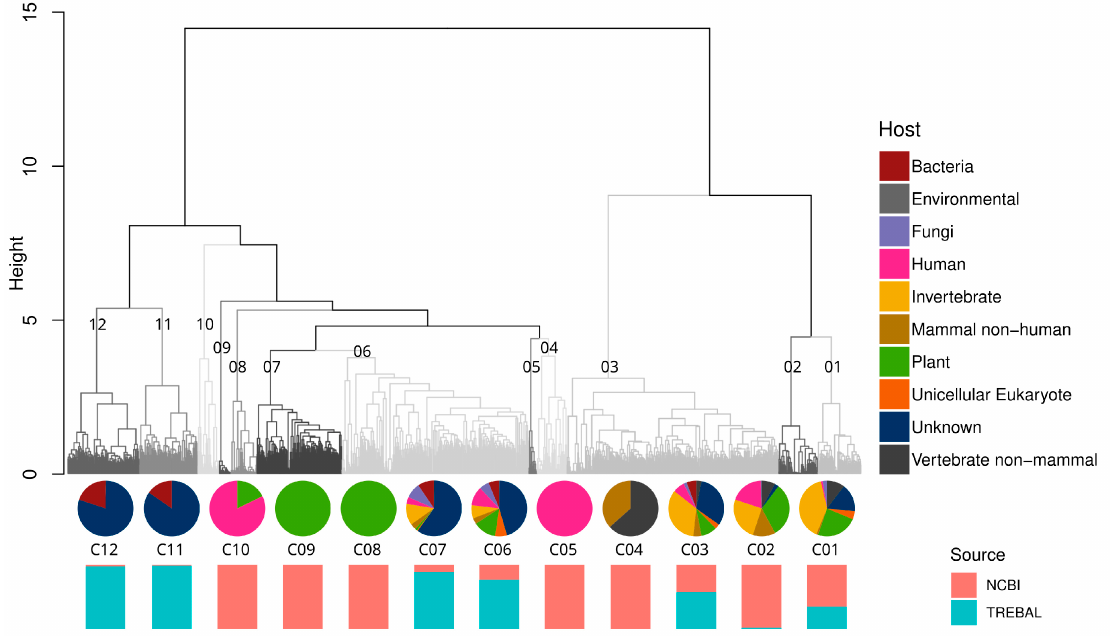
Figure 3. Hierarchical clustering analysis of 2266 RNA-dependent RNA polymerase (RdRP) predicted protein sequences from Trebal and NCBI RefSeq database based on Bray–Curtis amino acid distance ( k = 2). Dendrogram was divided in 12 main cluster based on the “unrooted” dendrogram. Pie charts represent the frequency of sequences in each cluster classified by the putative host trough LCA algorithm. Bar charts represent the source (NCBI or Trebal) from which sequences were retrieved inside each cluster.